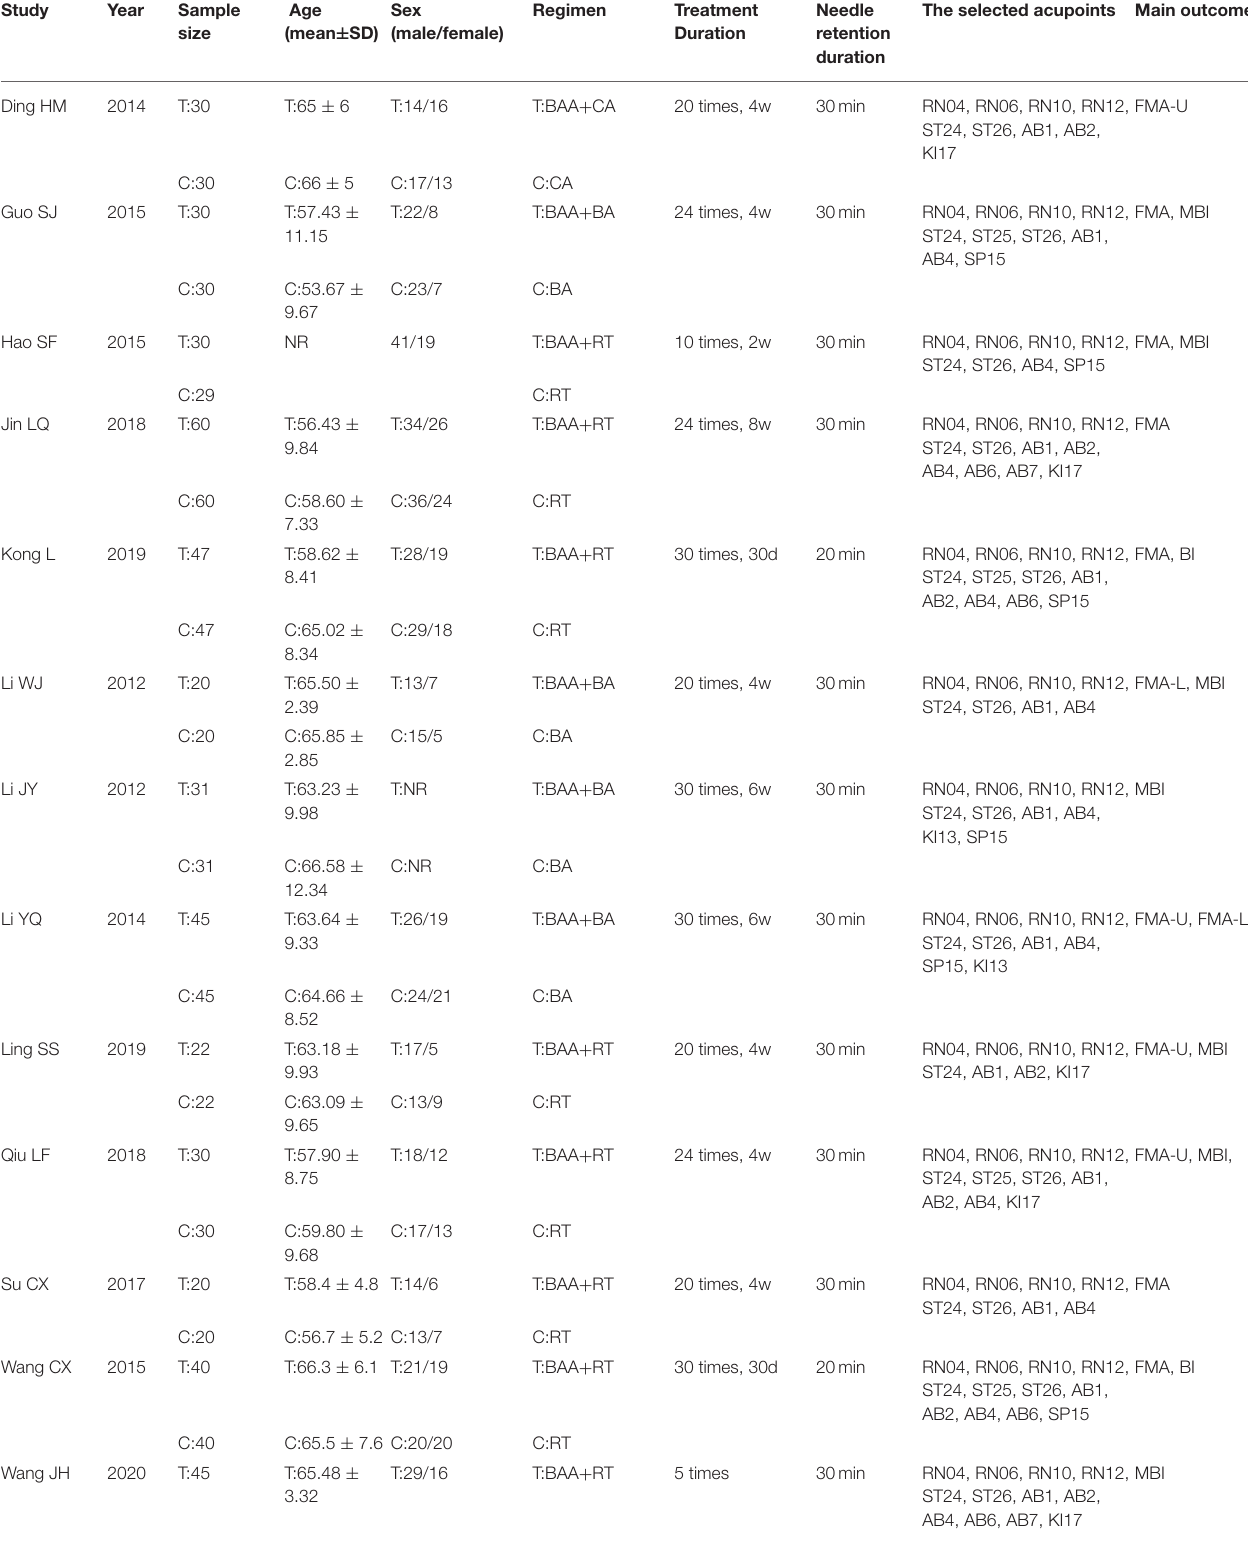
TABLE 1 | General information of included trials. Study Sample